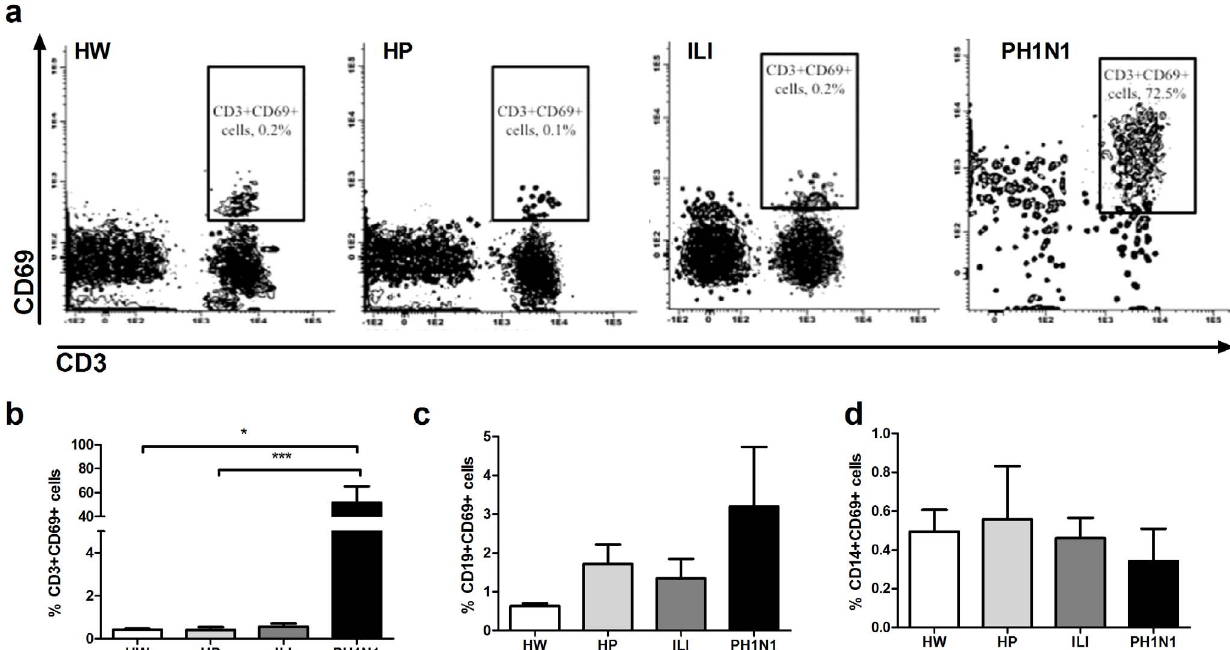
Figure 1. Higher percentage of CD69 + lymphocytes in H1N1pdm2009 virus-infected pregnant women. The peripheral blood leukocytes from the HW, HP, ILI and PH1N1 women were immunostained with CD3-, CD19-, CD14- and CD69-specific antibodies and analyzed by flow cytometry. Representative data of each group are shown in the dot plots for CD69 + CD3 + cells (a). The distribution of CD69 expression on CD3 2 (b), CD19 2 (c) or CD14 2 (d) gated cells. The Kruskal-Wallis test with Dunn’s multiple comparison post-test was performed using the GraphPad Software. The significance values were *p , 0.05, **p , 0.01, ***p , 0.001.